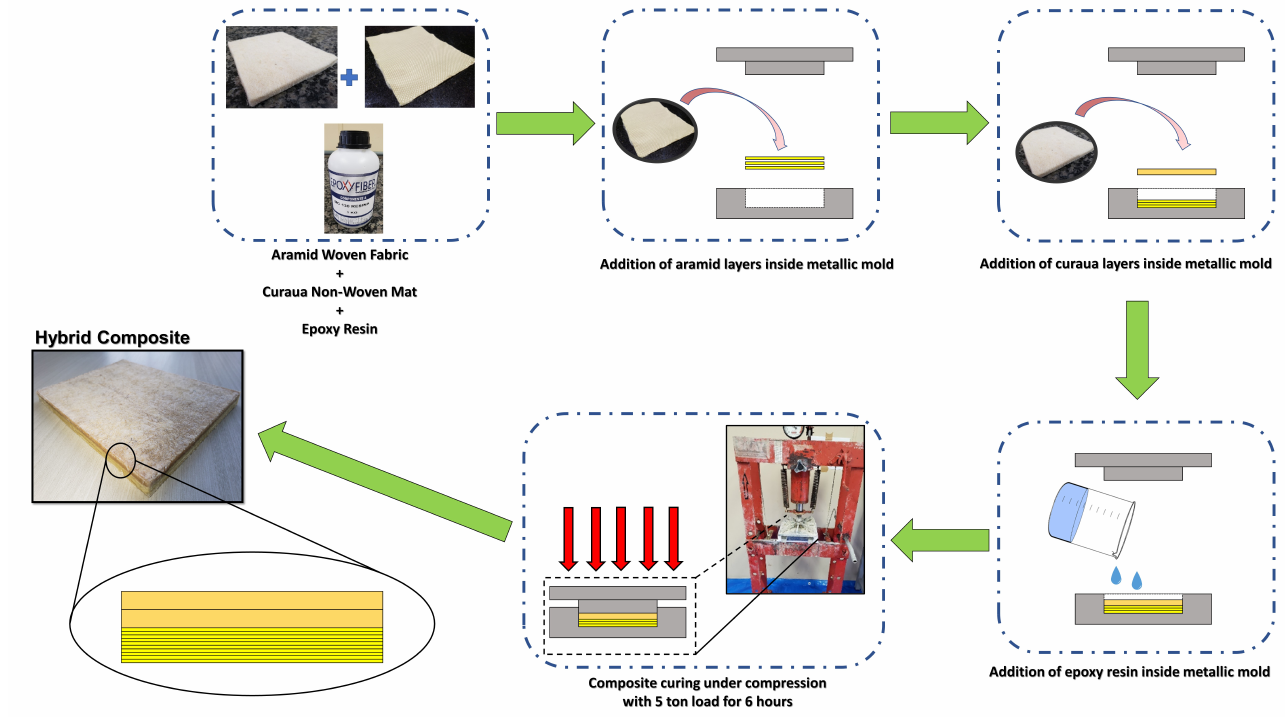
Figure 1. Scheme of production process for hybrid laminated